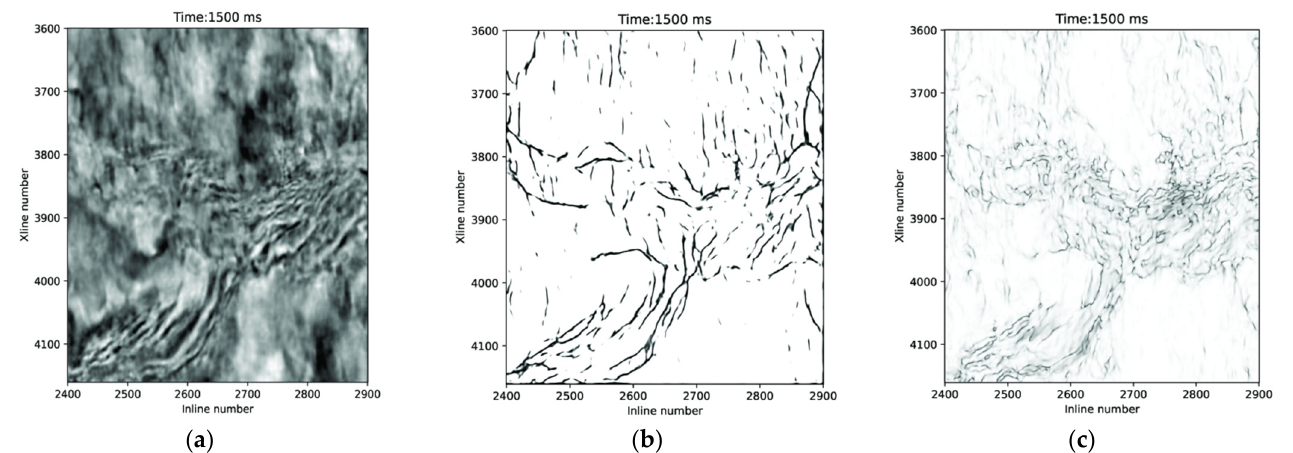
Figure 13. ( a ) A time slice is displayed with faults that are detected via ( b ) the trained FCN model and ( c ) fault likelihood.